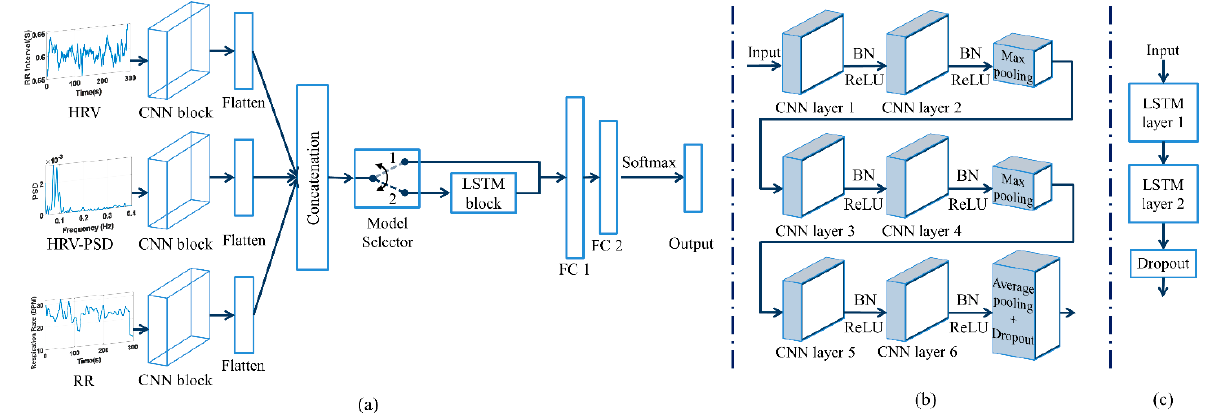
Figure 6. ( a ) The model architecture of the CNN and the hybrid CNN-RNN models. The model selector block is a hypothetical block to show the difference between the two models: state 1 shows the CNN model and state 2 shows the CNN-LSTM model; ( b ) details of the inner layers in the CNN blocks; ( c ) details of the LSTM block. CNN: convolutional neural network, HRV: heart rate